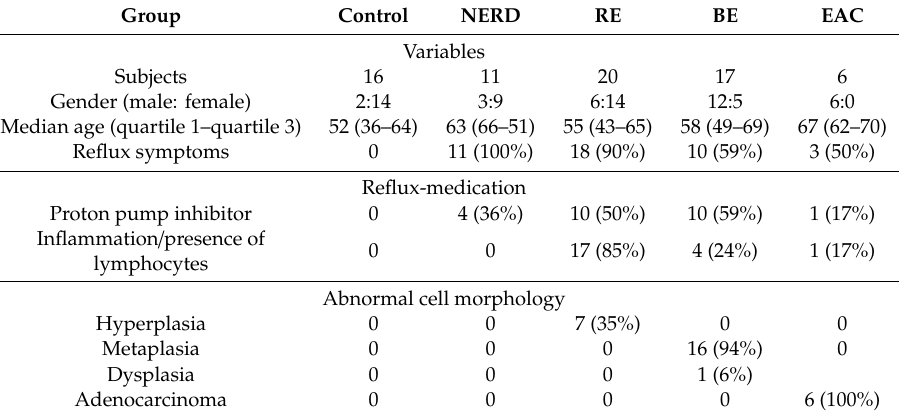
Table 1. Subject